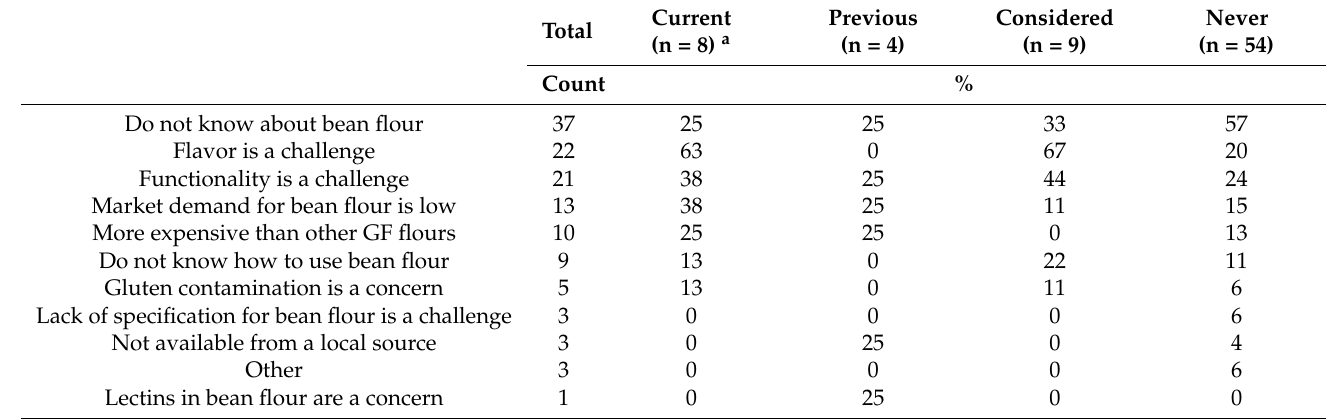
Table 5. Participants’ impression on bean flour by user